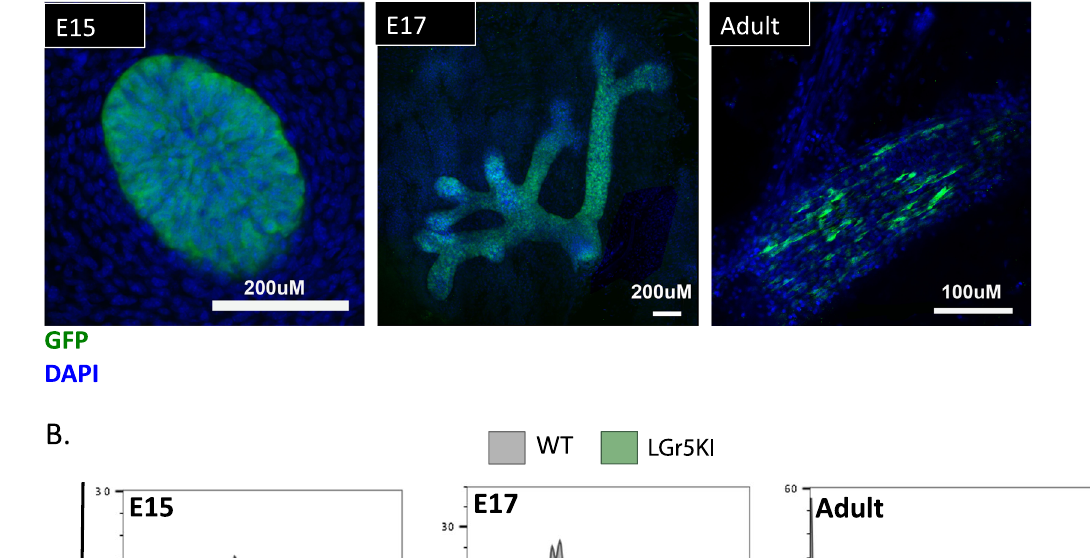
Fig. 1 Lgr5 expression pro fi led in the mammary gland throughout development. a Mammary glands were isolated from Lgr5KI embryos at embryonic days 15 and 17 (E15 and E17) and from Lgr5KI virgin adults. Whole mounts were immunostained for GFP ( green ) and DAPI ( blue ), and analyzed on a confocal microscope. b Single-cell suspensions were prepared from the mammary glands of Lgr5KI mice at stages E15, E17, and adult and stained for DAPI and EpCAM. Viable (DAPI negative), epithelial (EpCAM positive) cells were then measured for GFP expression through FACS analysis. The percentage of cells that were GFP positive ( green ) was measured by designating a threshold above which the epithelial cells of the wild-type littermates ( gray ) measured zero. c Viable single cells were sorted for GFP expression using the parameters mentioned in Fig. 1b and analyzed for expression of EpCAM and CD49f